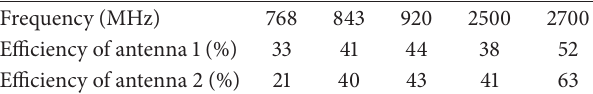
Table 2: Measured total efficiency of antenna 1 and antenna